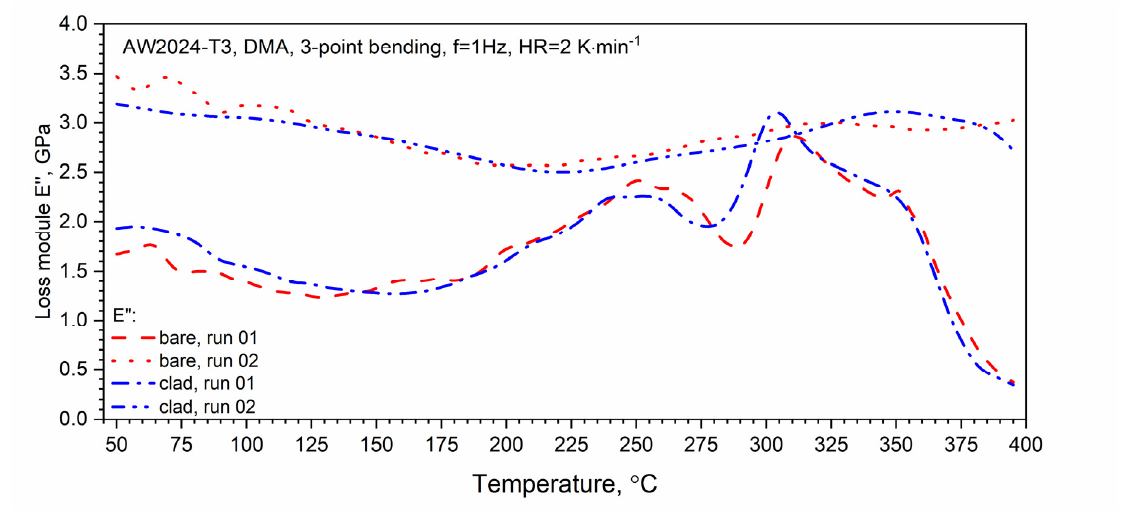
Figure 16. Dynamic loss modulus E ’’ of bare and clad AW-2024-T3 (first and second runs).